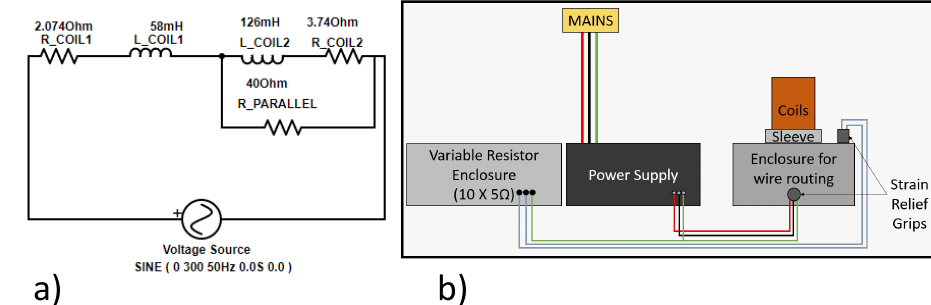
Figure 10. ( a ) Circuit representation of the coils + resistor in parallel setup. ( b ) Schematic of the experimental apparatus with adjusted strength of